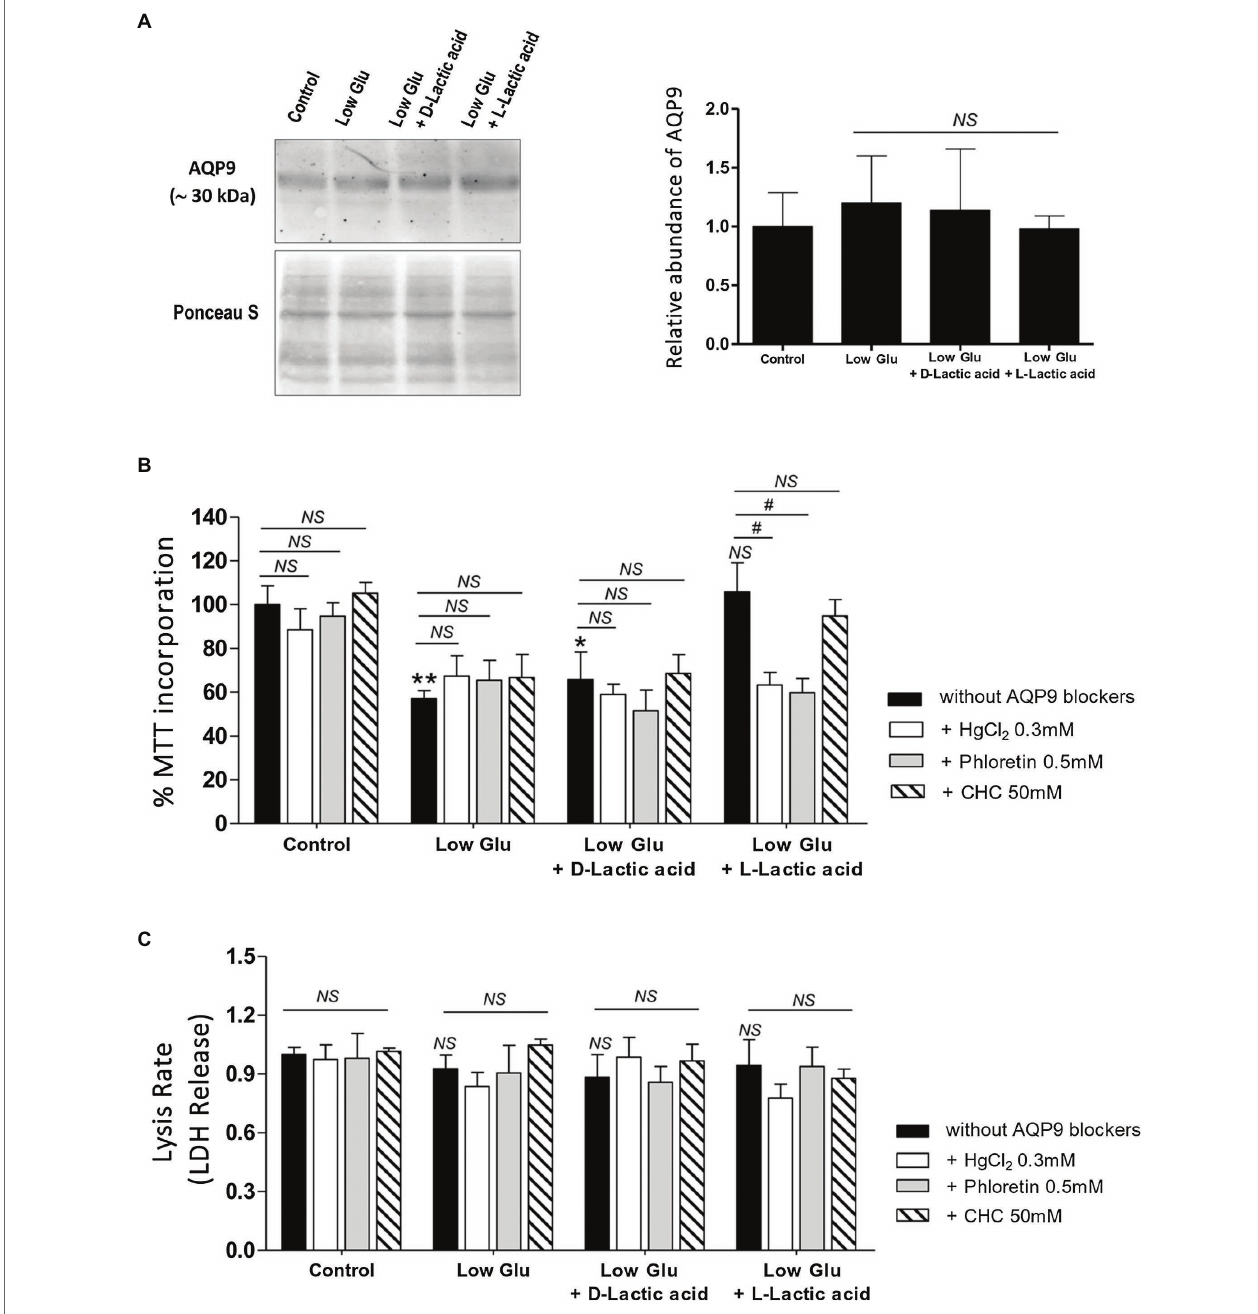
FIGURE 1 | Effect of the availability of glucose and lactate on the expression of Aquaporin-9 (AQP9) and the viability of explants. Explants were cultured in the different conditions: Control (25 mM glucose medium), Low Glucose medium (Low Glu, 5 mM glucose), Low Glucose medium with D-Lactic acid, and Low Glucose medium with L-Lactic acid. (A) Expression of AQP9. Representative Western blot for AQP9 protein expression in different culture conditions. Densitometry of immunoblot, the values were plotted as the relative abundance of AQP9 expression. ( n = 6 placentas; NS=Non-significant). (B) 3-(4,5-dimethylthiazol-2-yl)-2,5- diphenyl tetrazolium bromide (MTT) incorporation. The viability was evaluated by MTT assay in placental explants cultured in the different conditions. CHC was used to block MTCs. The effect of 0.5 mM Phloretin or 0.3 mM HgCl 2 to block AQP9 was evaluated in all the treatments. All the experiments were independently conducted in triplicate. Data are expressed as means ± SEM. ( n = 6 placentas; * p < 0.05 and ** p < 0.001 compared to control without blockers, NS = Non-significant; and # p < 0.05 compared to low glucose medium with L-lactic acid without blockers). (C) Lactate dehydrogenase (LDH) release. LDH release assay was performed for determining the rate of cell death by necrosis in placental explants cultured in different conditions. CHC was used to block MTCs. The effect of 0.5 mM Phloretin or 0.3 mM HgCl 2 to block AQP9 was evaluated in all the treatments. The experiments were independently conducted in triplicate at least three times. Data are expressed as means ± SEM. ( n = 6 placentas; NS = Non-significant). All the experiments were independently conducted in triplicates at least three